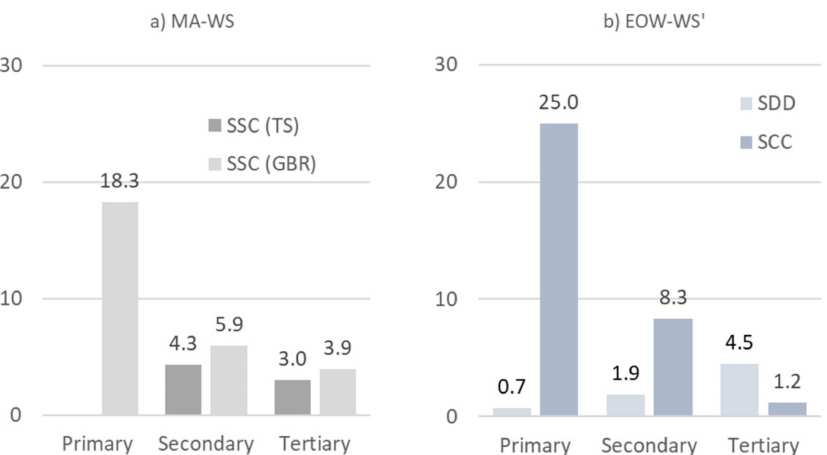
Figure 3. ( a ) Mean SSC measured in TS at the October 2016 survey sites (mg L − 1 , light grey and